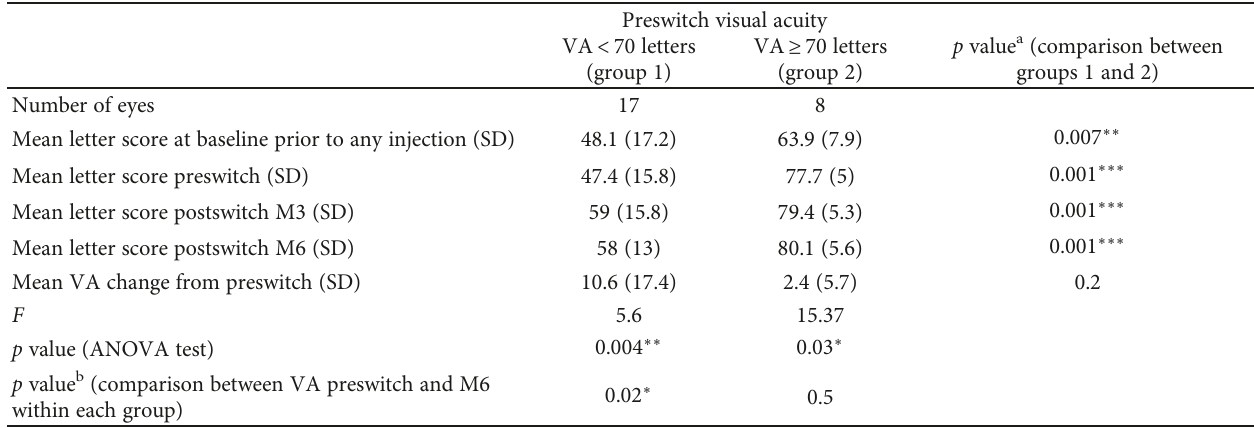
Table 5: Subgroup analysis of the impact of the preswitch VA ( < or ≥ 70 letters) on VA.